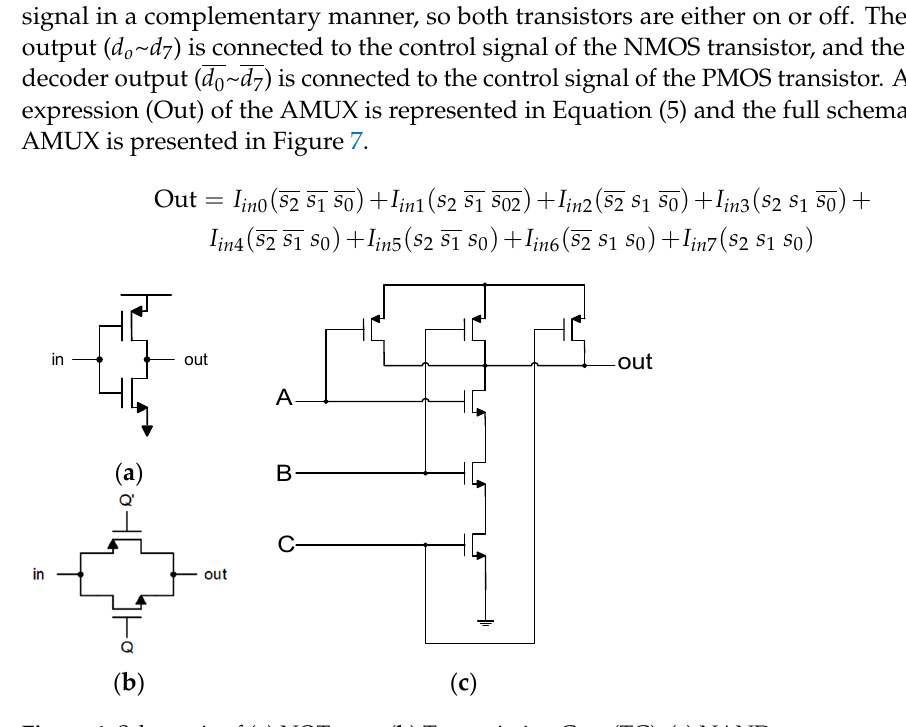
Figure 6. Schematic of ( a ) NOT gate; ( b ) Transmission Gate (TG); ( c ) NAND gate.